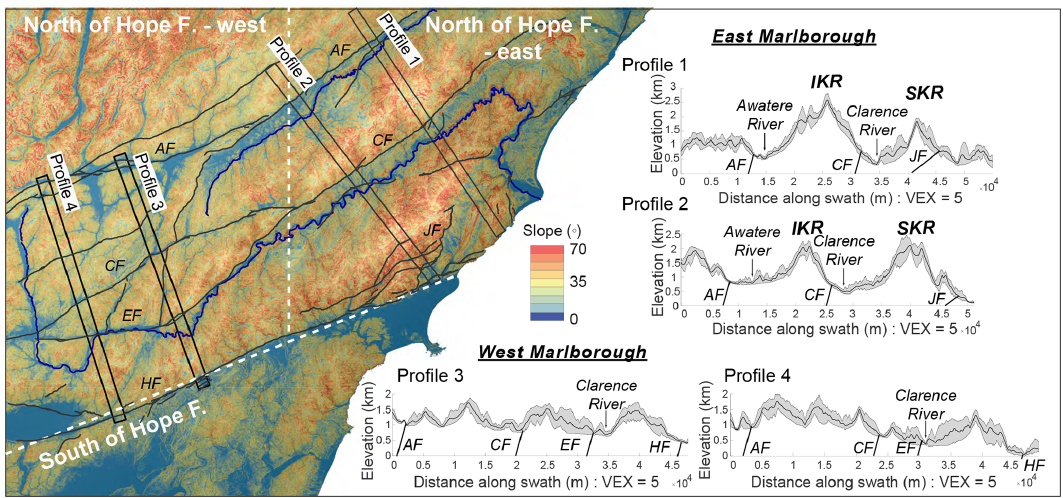
Figure 2. Slope map overlaying a shaded relief map of the study site (left). Topographic swath profiles generated with the Topographic Analysis Kit (right) (Forte and Whipple, 2019). Locations of profiles shown on slope map and labeled as profiles 1 and 2 (within eastern MFS) and profiles 3 and 4 (within western MFS). Dashed white lines show boundaries between three geomorphic domains based on differences in topography: western MFS, north of Hope Fault, eastern MFS, north of Hope Fault, and south of Hope Fault. AF – Awatere Fault, CF – Clarence Fault, EF – Elliott Fault, JF – Jordan fault (Jordan Thrust), and HF – Hope